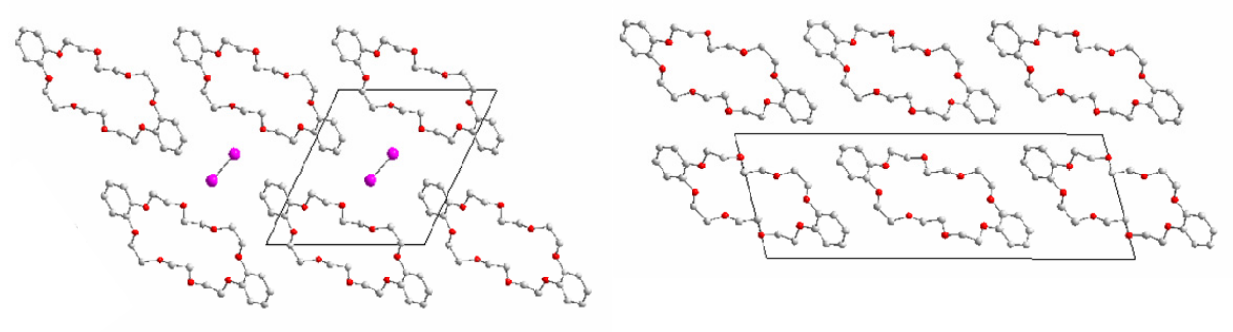
Figure 2. Comparison of the crystal structures of (I (right). Views down the short axes, a = 485.0(1) and b = 491.3(2) pm, respectively.